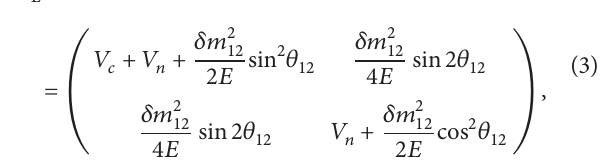
Figure 1: Magnetic field